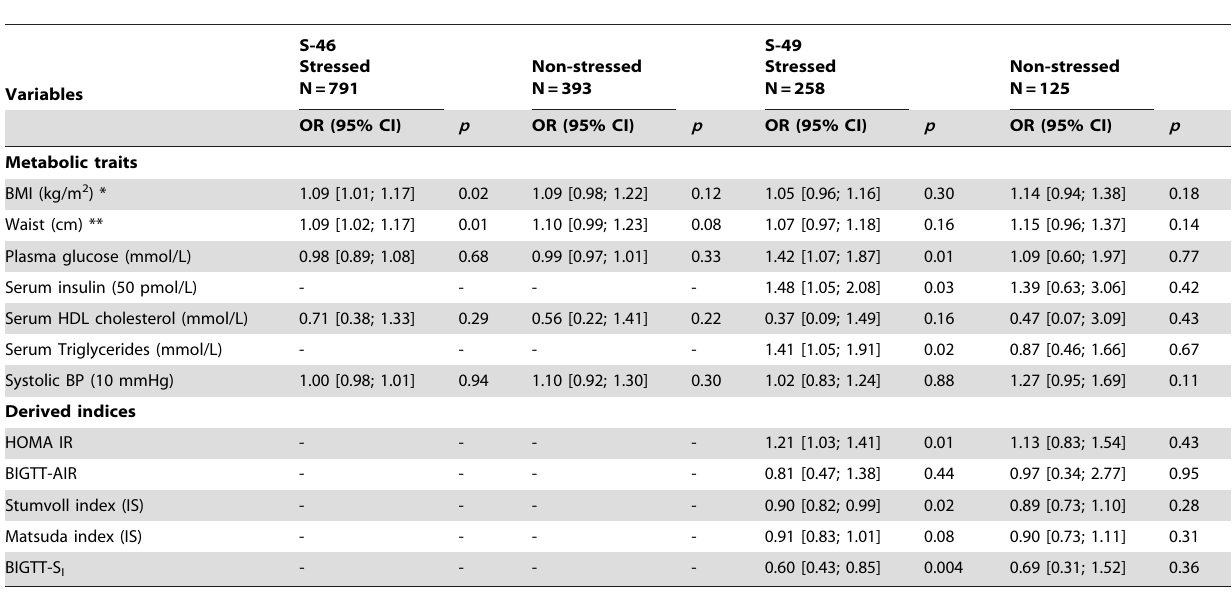
Table 4. Metabolic traits and OGTT-derived indices in relation to APOE rs439401 at survey 46 (S-46) and survey 49 (S-49). OR (95% confidence intervals) in stressed individuals homozygous for the minor